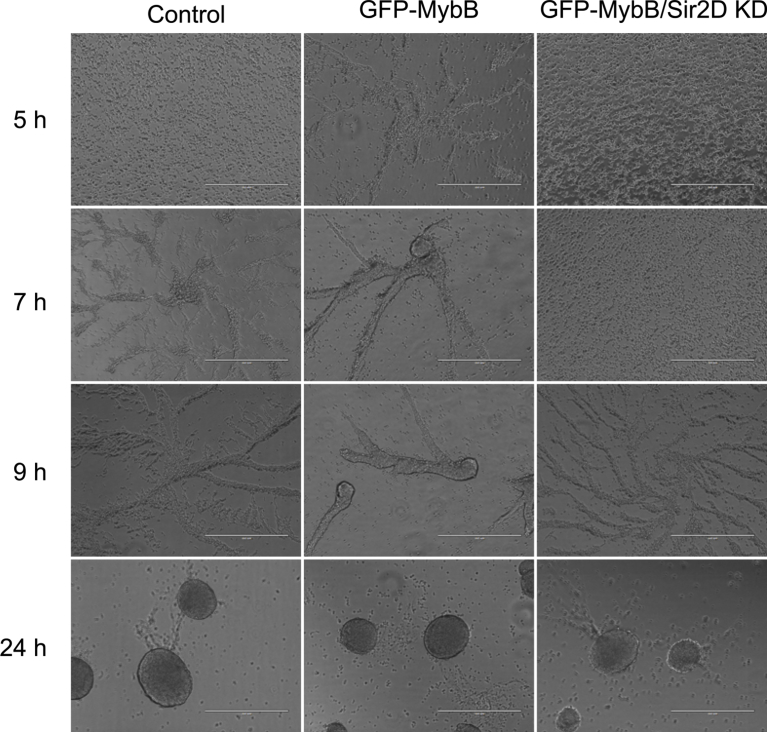
Supplementary Fig. S5.eps